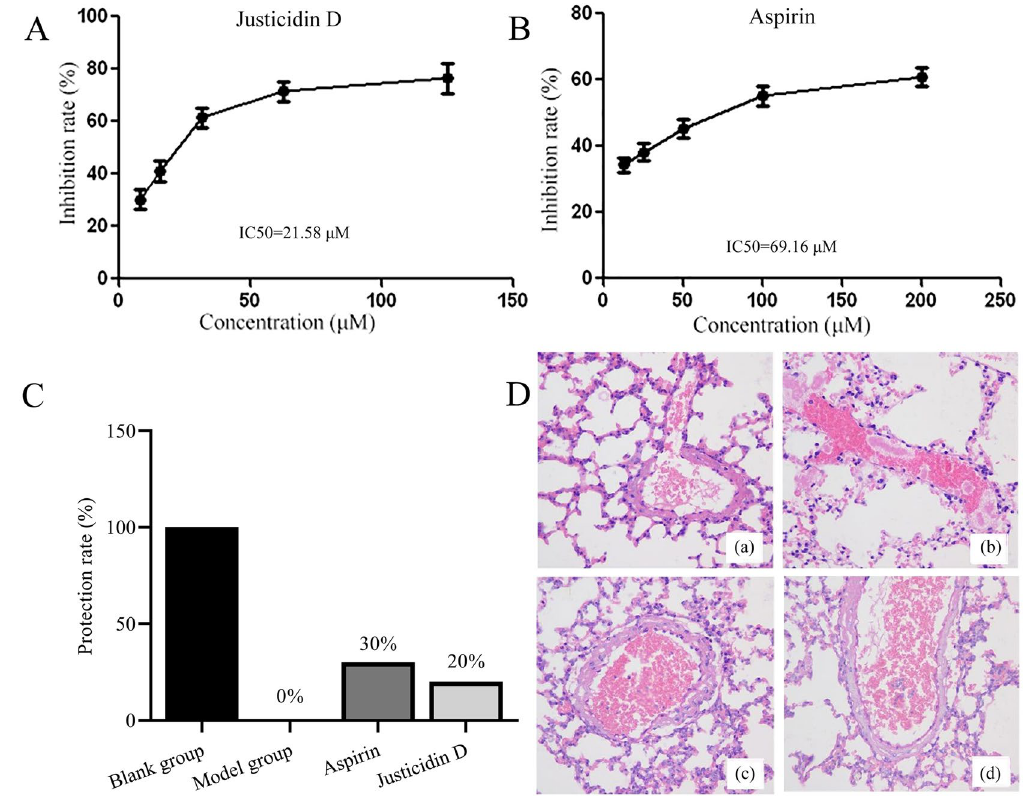
Figure 10. ( A , B ) represent the inhibitory effects of justicidin D and aspirin on platelet aggregation, respectively. ( C ) The protective effect of justicidin D and aspirin on pulmonary embolism in mice (n = 10. All survived in the control group and all died in the model group. The protection rate of justicidin D was 20%, and the protection rate of aspirin was 30%). ( D ) HE (400 ×) staining of lungs of mice with pulmonary embolism, ( a ) blank group,